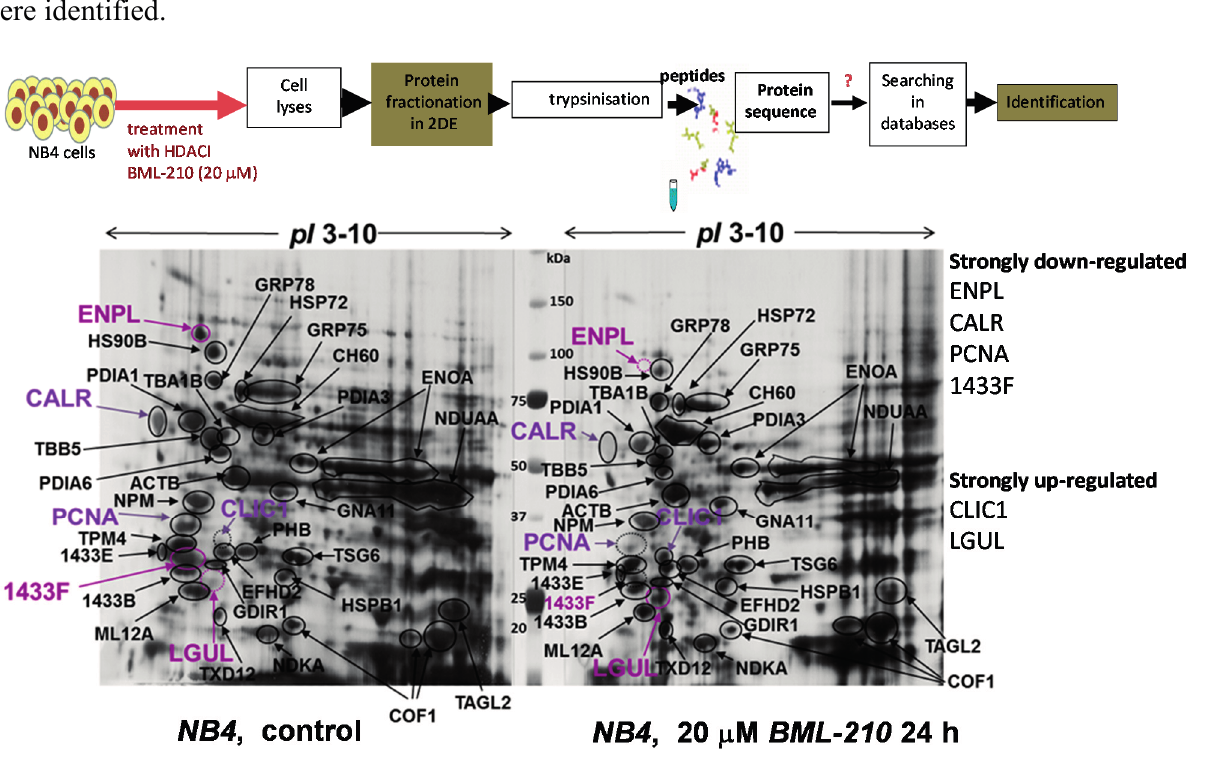
Figure 3. Proteomic analysis of proteins after BML-210 treatment. Proteins from untreated NB4 cells and cells treated with 20 μ M BML-210 for 24 h fractionated in 2-DE system and visualized by Coomassie staining. Identified proteins shown, are listed in Table 1. Migration of the molecular size marker proteins is indicated in the center